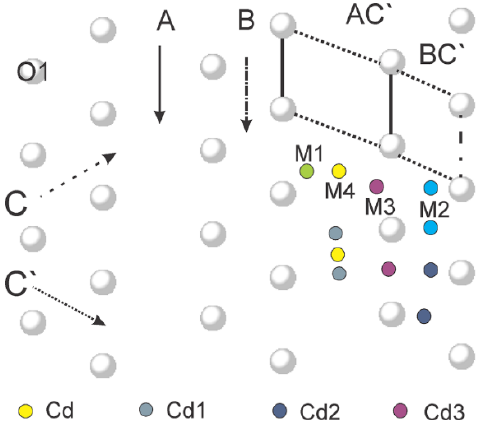
Figure 6. Gallery representation of the structure of Cd-clinoptilolite: distribution of O1 atoms in the plane (020), with directions of lanes A, B, C, and C` and location of the extra-framework cation po- the plane (020), with directions of lanes A, B, C, and C’ and location of the extra-framework cation sitions and Cd positions. positions and Cd